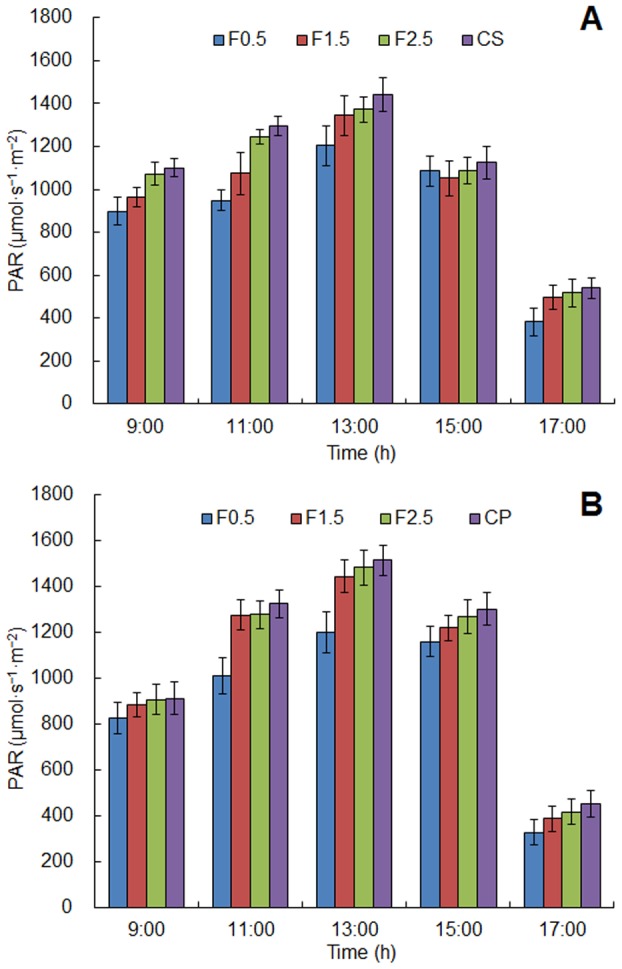
Diurnal variation of photosynthetically active radiation (PAR) for the intercropping systems and its control (A. apple–soybean and B. apple–peanut).F0.5, F1.5 and F2.5 were used to represent the sampling points which had different distance (0.5 m, 1.5 m and 2.5 m) from the tree row. Error bars indicate standard deviation.